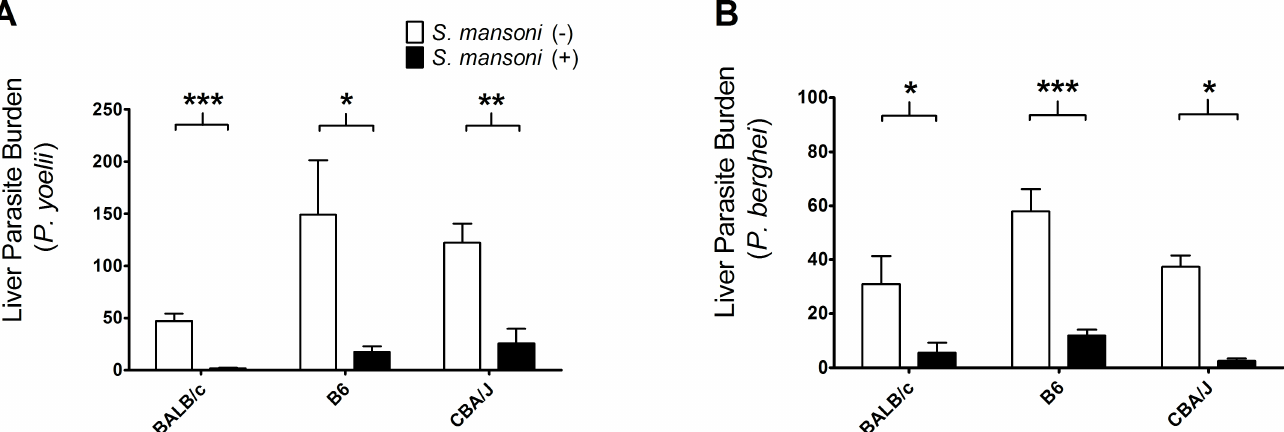
Fig 2. Malaria parasite liver burden in BALB/c, C57BL/6, and CBA/J mice. (A) Copy number of Plasmodium yoelii 18s RNA gene per 1×10 6 mouse G3PDH gene measured at 42 h post sporozoite inoculation. Female BALB/c, B6, and CBA/J mice (N = 5) infected with 50 Schistosoma mansoni -cercaria 10 weeks previously were challenged with 1,500 SPZ of P . yoelii along with S . mansoni- non-infected controls. BALB/c: (cid:3)(cid:3)(cid:3) P < 0.001, t = 6.283, df = 8; B6: (cid:3) P < 0.05, t = 2.511, df = 8; CBA: (cid:3)(cid:3) P < 0.01, t = 4.220, df = 7. (B) Copy number of Plasmodium berghei 18s RNA gene per 1×10 6 mouse G3PDH gene measured at 42 h post sporozoite inoculation. Female BALB/c, B6, and CBA/J mice (N = 5) infected with 50 S . mansoni -cercaria 10 weeks previously were challenged with 1,500 SPZ of P . berghei along with S . mansoni- non-infected controls. BALB/c: (cid:3) P < 0.05, t = 2.306, df = 8; B6: (cid:3)(cid:3)(cid:3) P < 0.001, t = 5.336, df = 8; CBA: (cid:3) P < 0.05, t = 2.846, df = 7. All data were statistically examined using Student’s two-tailed